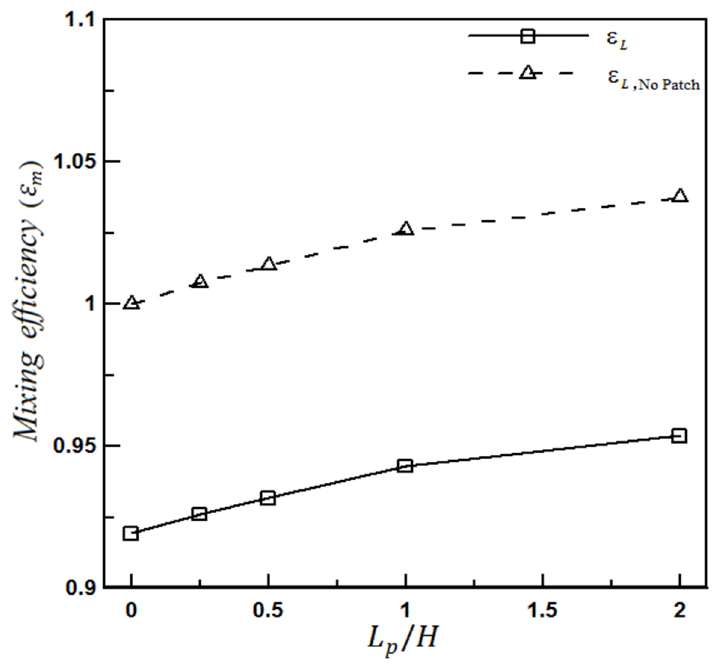
Figure 10. Effect of the heterogeneous patch size on mixing performance.